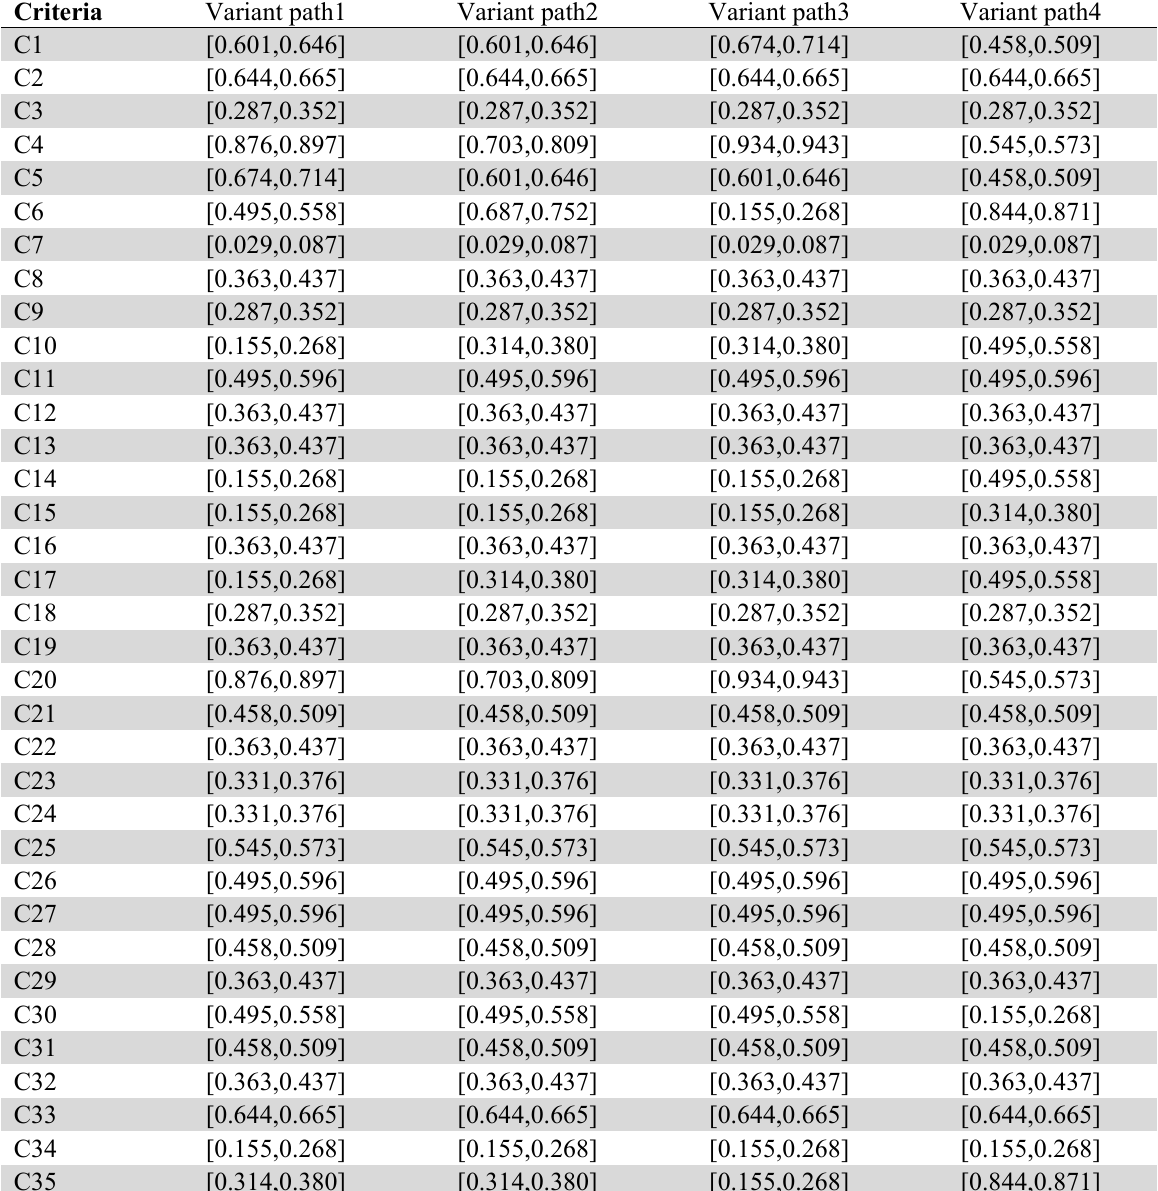
Calculation of Distance between the Reference Value & Comparison Values